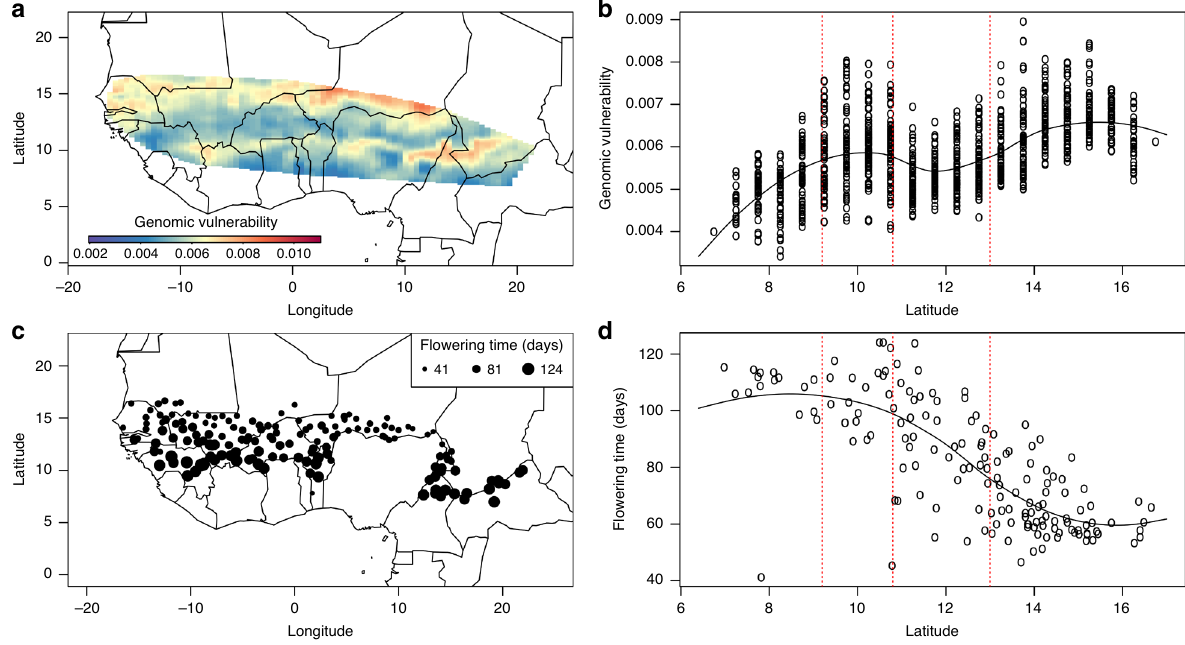
Fig. 3 Spatial distribution of genomic vulnerability relative to fl owering time. a Genomic vulnerability of pearl millet to climate change at the 2050 horizon. The gas emission scenario considered here is RCP8.5. b Genomic vulnerability of pearl millet cultivation as a function of latitude. Circles indicate the genomic vulnerability within the cultivation area plotted as a function of the latitude concerned. The curve of genomic vulnerability with respect to latitude was smoothed using the loc fi t R function. Red dotted lines separate latitudinal ranges with higher genomic vulnerability. c Flowering time of landraces depending on their location of origin. The size of the circle indicates the average fl owering time. d Flowering time of the landraces as a function of latitude. The curve of fl owering time as a function of latitude was drawn using the loc fi t R function. Red dotted lines separate latitudinal ranges with the highest genomic